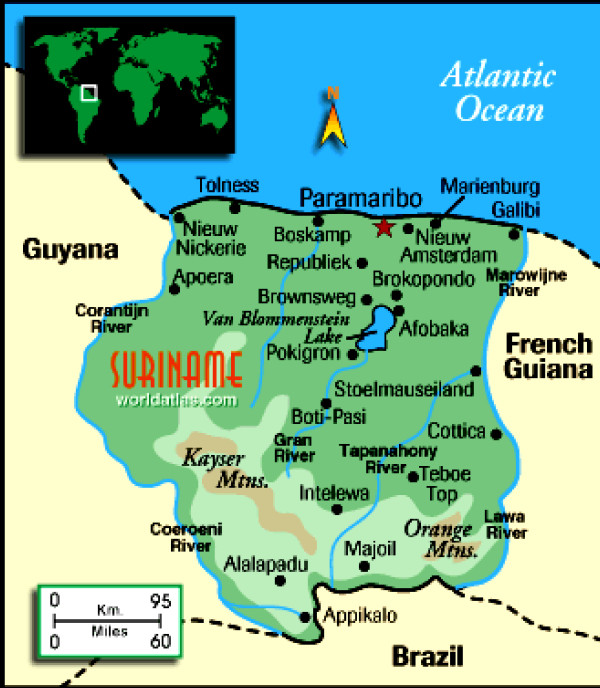
Map of Suriname.